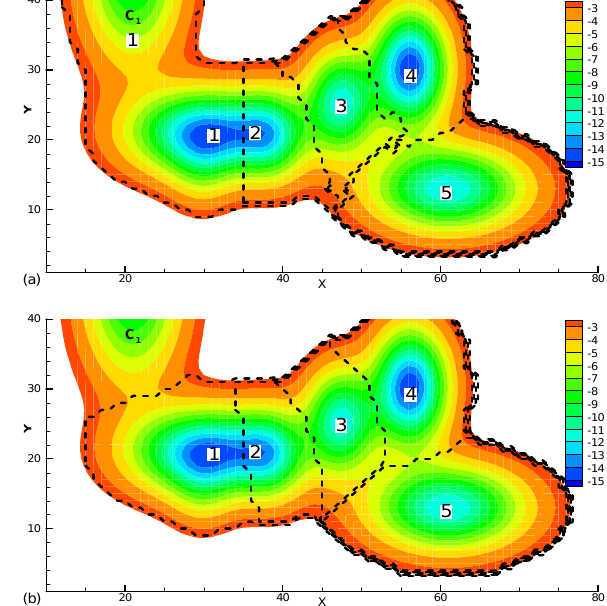
Figure 4. (a) Example of eddy splitting in simply connected re- gion, where the colour contours represent the SLA, and the num- bers identify each eddy. Part of an eddy C 1 is located at (10< x <30, 30< y <40) in this region. It was recognized as part of eddy 1 ac- cording to previous methods. (b) Same example as in (a) but by present splitting strategy. The new algorithm automatically elimi- nates eddy C 1 from the present region. The eddy boundaries are smoother in nature than those in (a)